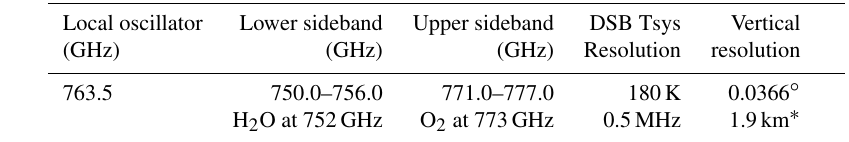
Table 3. The 763GHz spectral band.